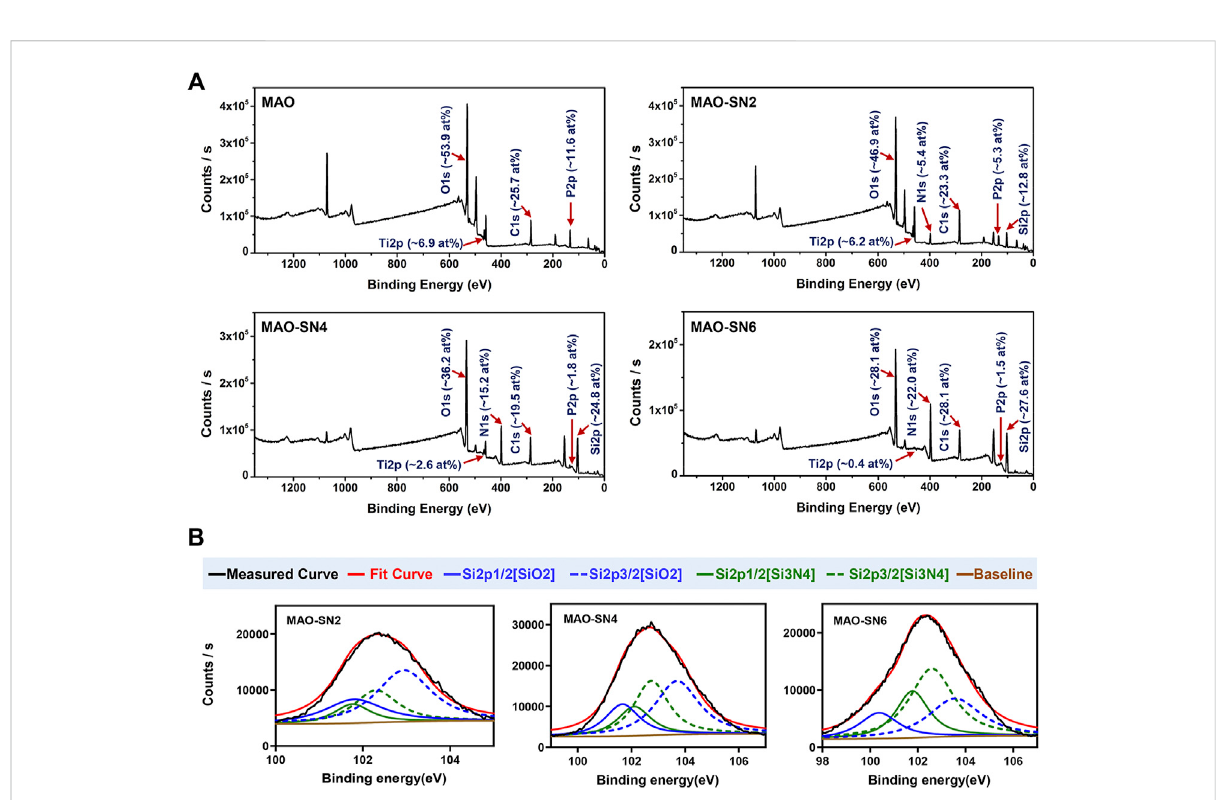
FIGURE 3 (A) XPS patterns and element contents of the MAO, MAO-SN2, MAO-SN4, and MAO-SN6 samples. (B) Split- fi tting spectra of the Si2p peaks in different